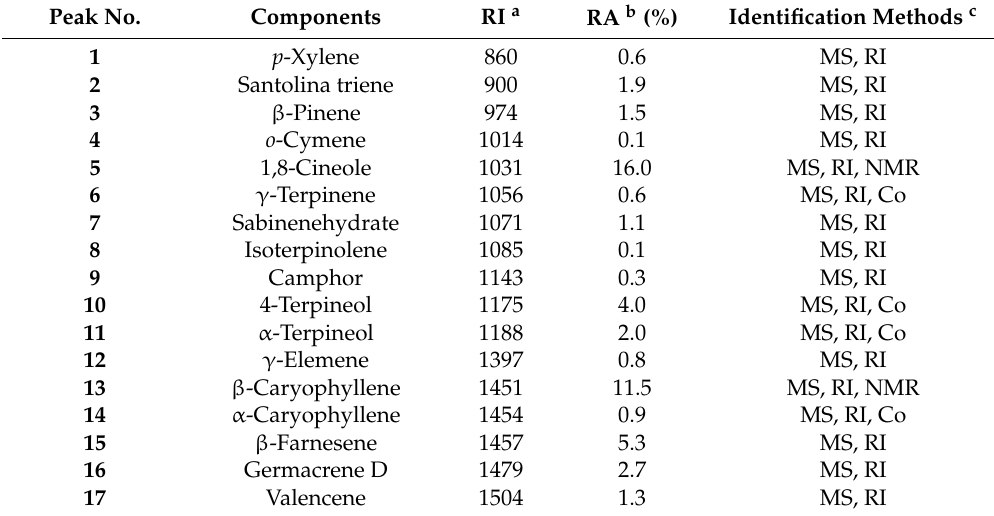
Table 1. Results of chemical composition of the essential